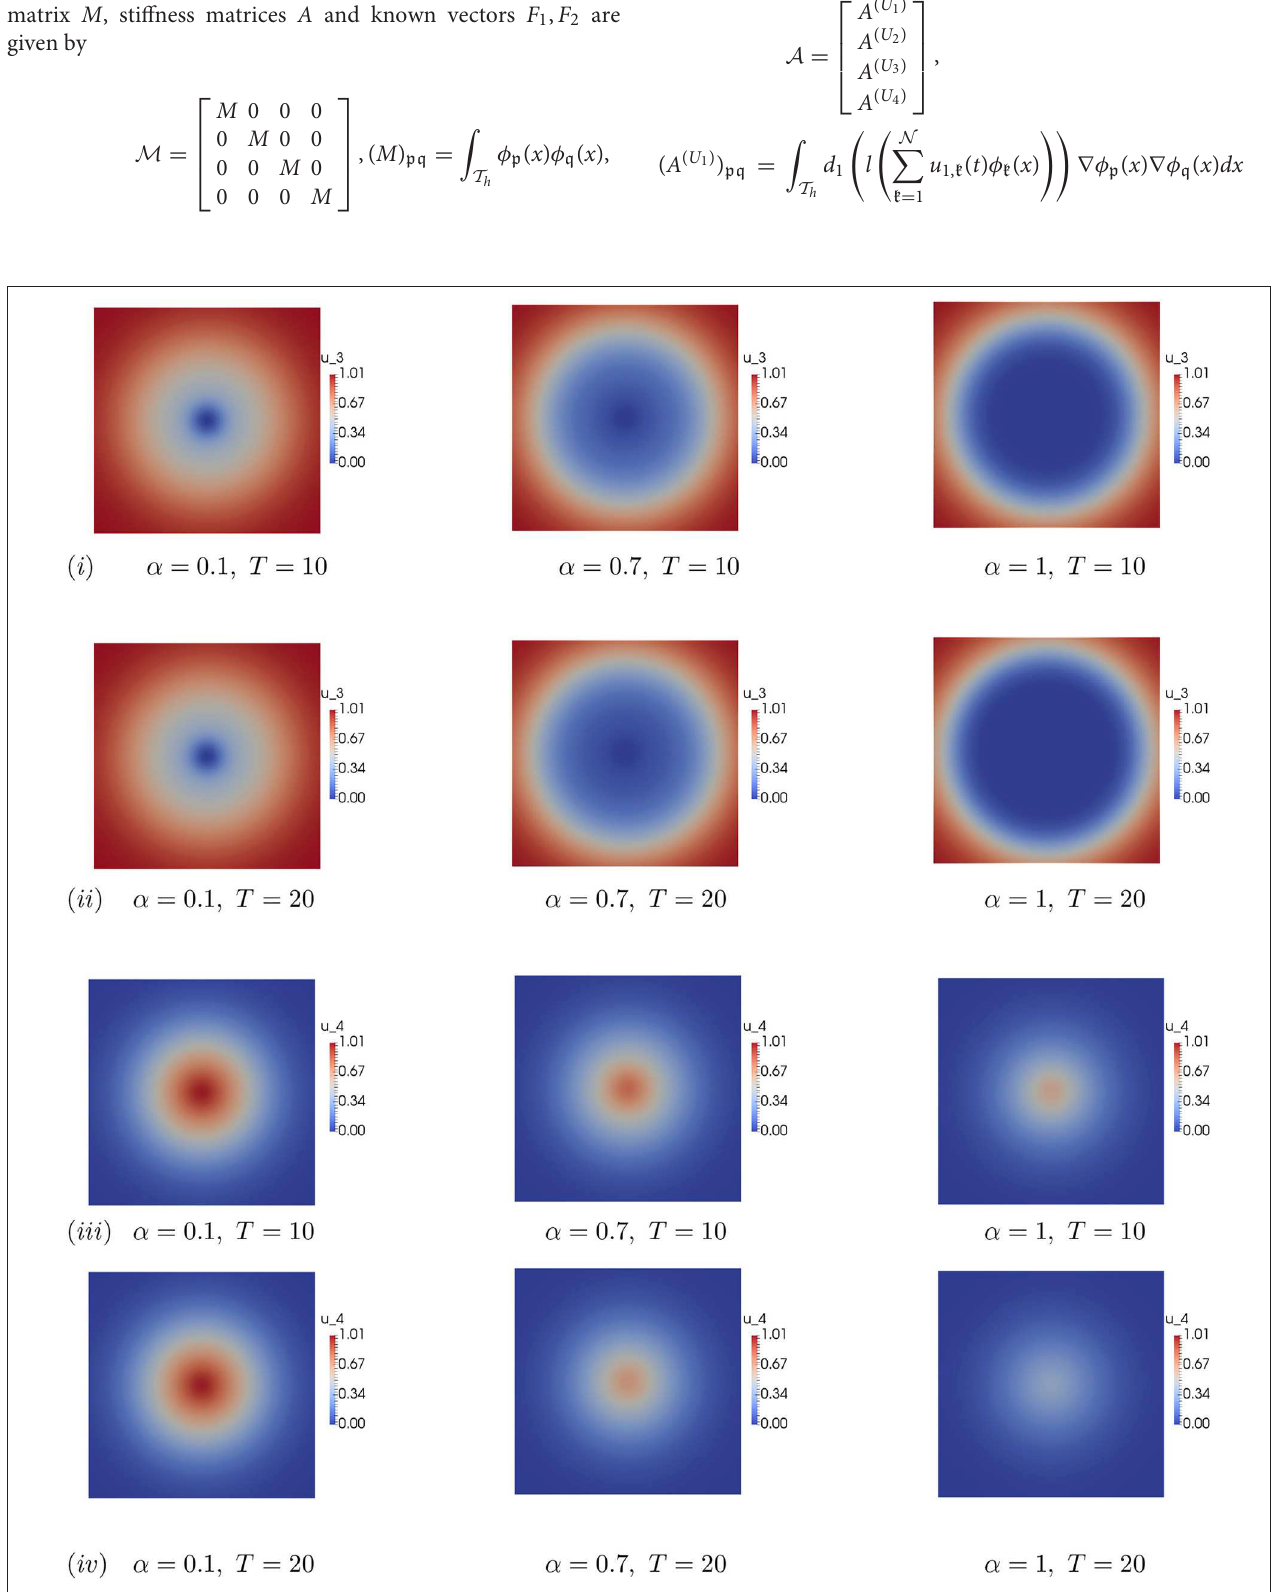
FIGURE 2 | Evaluation of u 3 and u 4 at T = 10, 20 with the different values of α = 0.1,0.7, and 1.